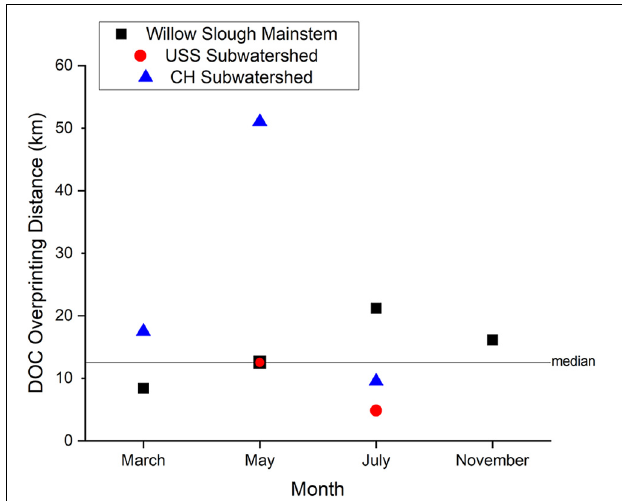
FIGURE 6 | Dissolved Organic Carbon (DOC) concentration overprinting distance for the Willow Slough watershed and for the Union School Slough and Chickahominy/Dry Slough subwatersheds. Horizontal line shows watershed median overprinting distance during the entire study. Positive overprinting distances indicate gain of DOC downstream, while the single negative value reflects DOC loss. Note that overprinting distance values closer to zero indicate stronger watershed influence on DOC concentrations, whereas larger numbers reveal weaker influence of a watershed on its passing